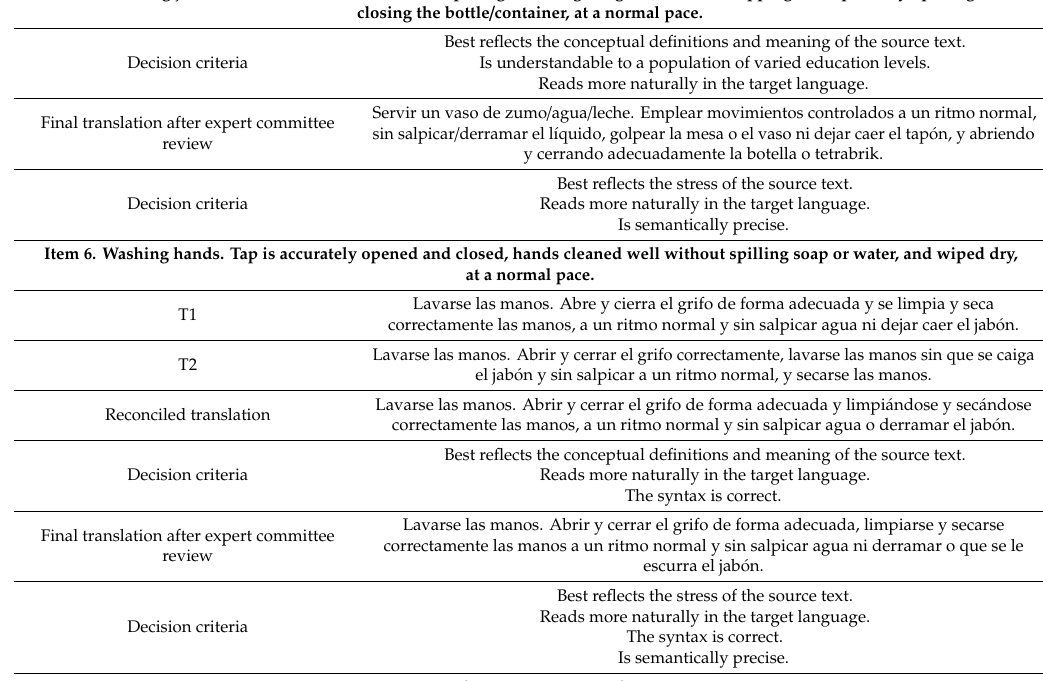
Best reflects the stress of the source text. Reads more naturally in the target language. The syntax is correct. Is semantically precise.